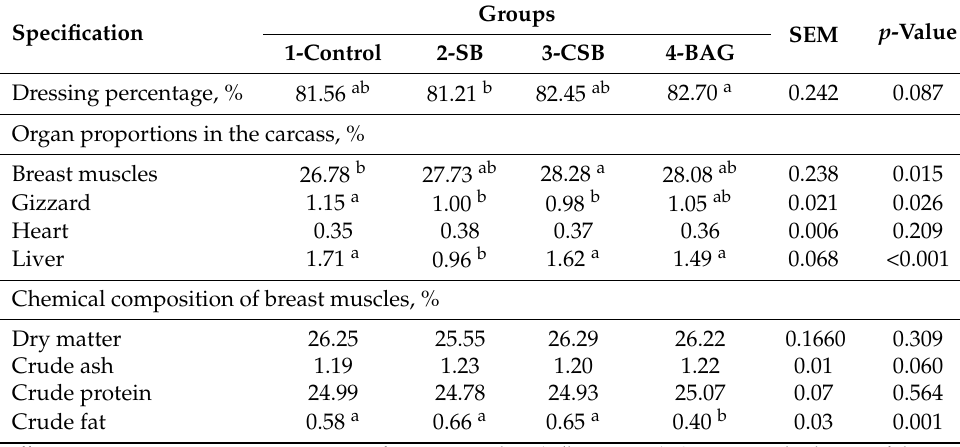
Table 3. Carcass quality characteristics and chemical composition of breast muscles in 15-week- old